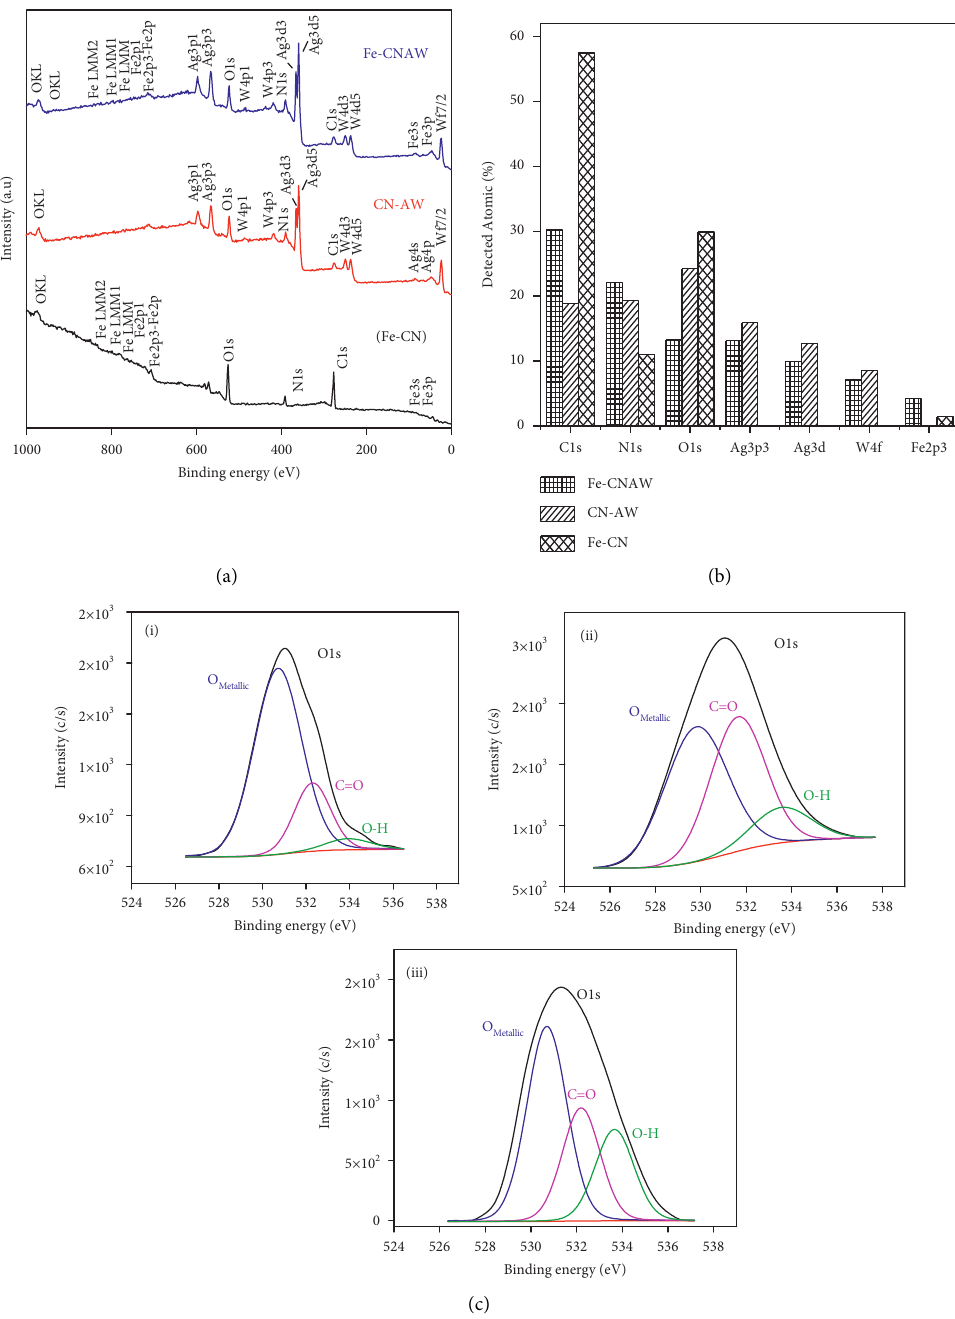
Figure 5: XPS (a) survey spectrum and (b) atomic percentage of various elements in Fe–CN, CN-AW, and Fe-CN-AW; (c) O1s functional groups for (i) Fe–CN, (ii) CN-AW, and (iii)